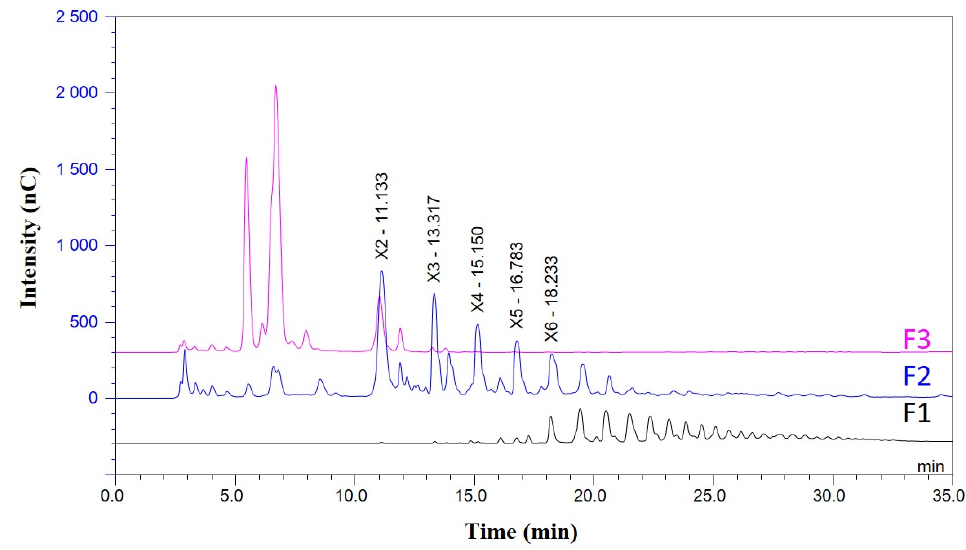
Figure 3. Distribution of XOS analysed by HPAEC-PAD in each fraction obtained by gel permeation chromatography.